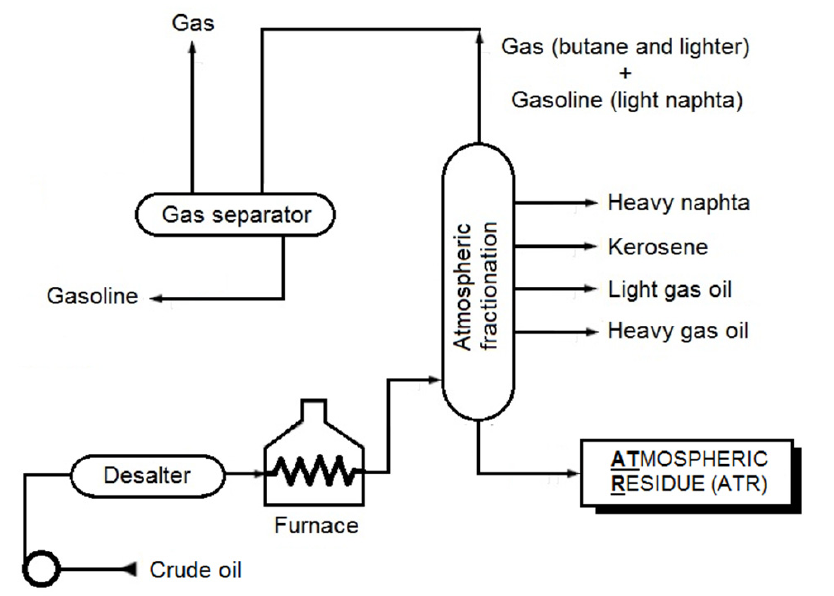
Figure 1. Scheme of the atmospheric distillation process in an oil refinery, showing the steps of the desalter, gas separator, and the raw hydrocarbon products, as well as the fraction of the atmospheric residue of petroleum at the bottom.